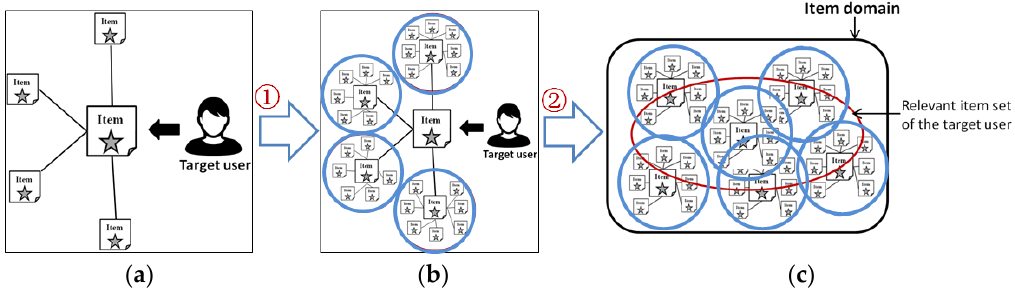
Figure 4. The description of covering-based rating prediction process. ① Based on the item-item similarity matrix, further select neighborhood for each similar item of the target item; ② compute covering degree between neighborhood of each similar item and target user’s preferences.